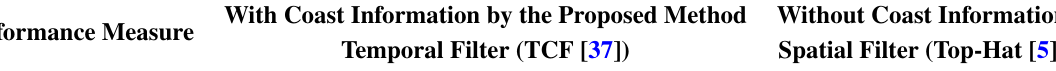
Infrared coastal region detection performance for the test database using the proposed method and the baseline method (mean-shift segmentation) [28]. FAR denotes the false alarm rate. TCF, temporal contrast filter.